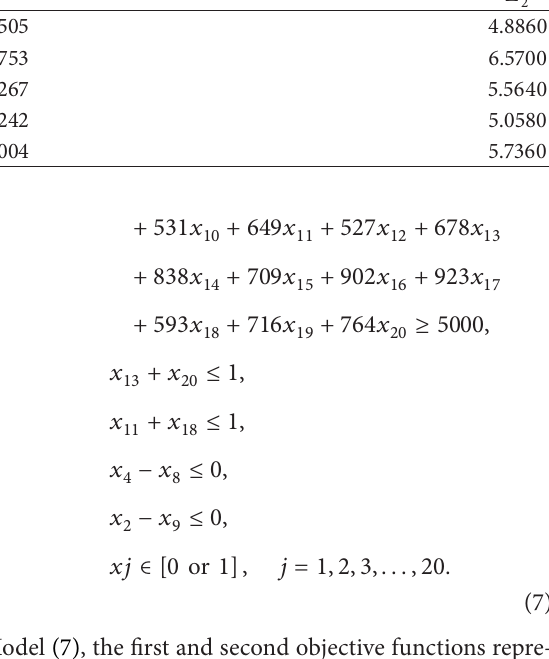
The algorithm execution time is 22.783 seconds. Table